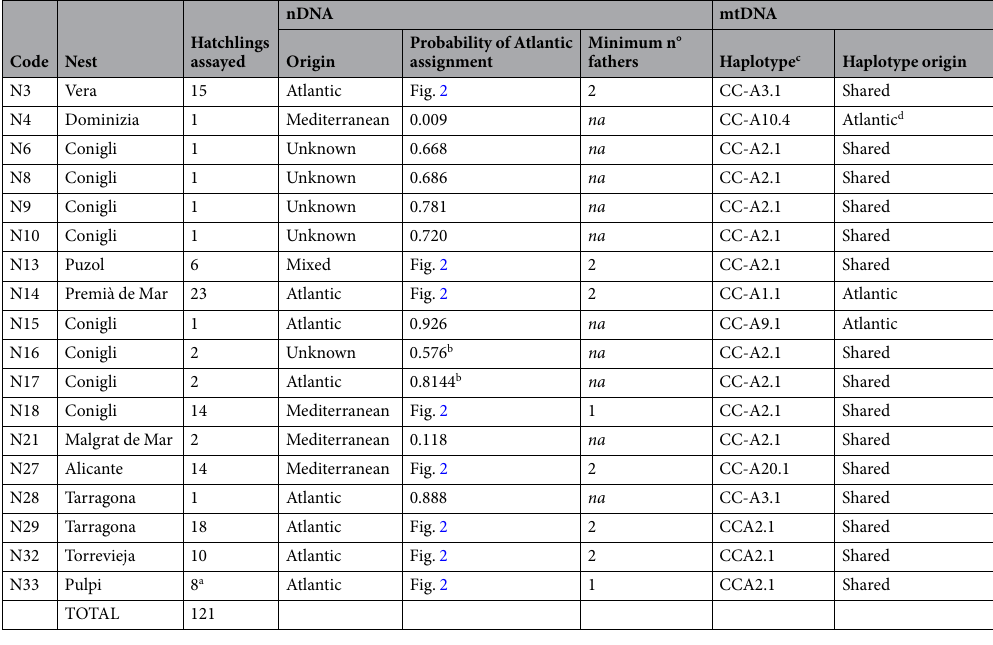
Table 2. Summary of the genetic results of the sporadic nest in the western Mediterranean. Nests coded as in Table 1. nDNA: results of the individual assignments of the hatchlings including the probabilities to be associated to the Atlantic nesting beaches and the minimum number of fathers detected. Bold values indicate high probability ( > 0.8) of individual assignments. mtDNA: haplotypes found and nesting area from where they have been reported (shared refers to both Atlantic and Mediterranean). na : not applicable as no more than two hatchlings were sampled for these nests as needed by GERUD v 2.0. a This includes one sample of the nesting female. b Mean value of the two samples. c GenBank accession numbers for the